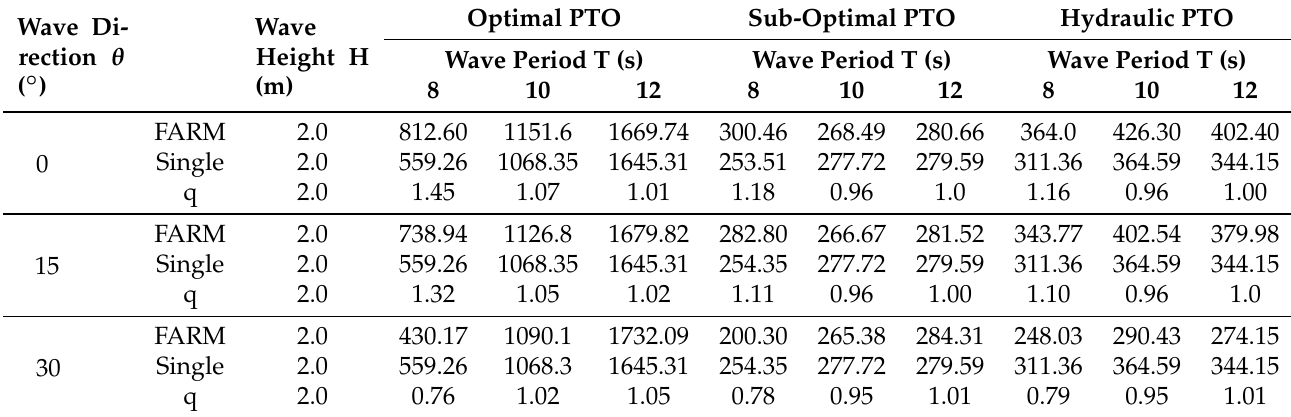
Table 3. Average power output for a farm of 21 HPA WECs for a linear optimal, a linear sub-optimal and a hydraulic PTO system.